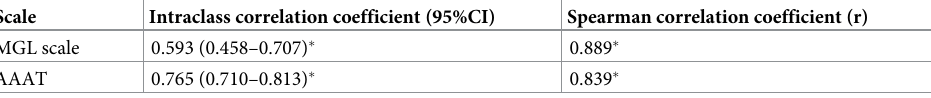
Table 4. Test-retest assessment using ICC and Pearson correlation between time 1 and time 2 (N =